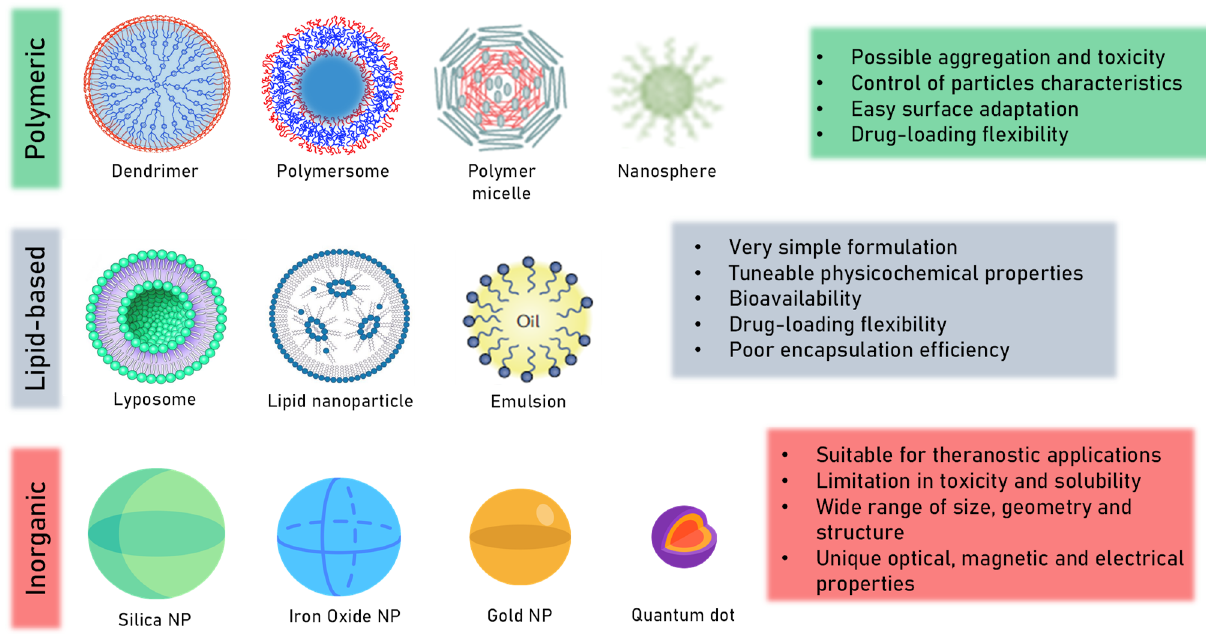
Figure 1. Classification of most common nanoparticles (NP) and their cargo, delivery and patient- response advantages and disadvantages.